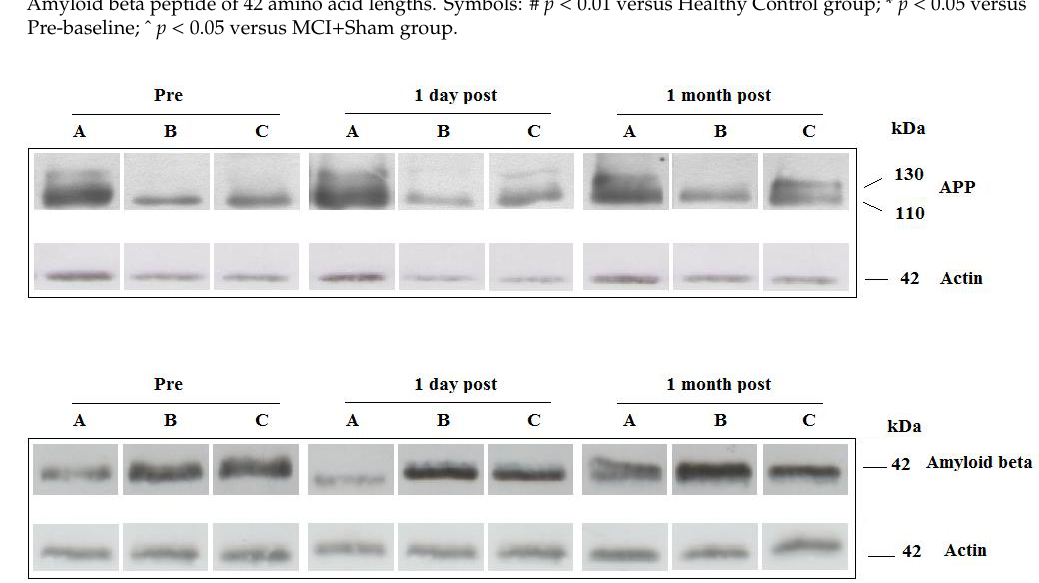
Figure 2. Western blot analysis of amyloid precursor protein (APP) forms (APP130 and APP110) and amyloid beta (Aβ) protein expression levels in the platelets collected from Healthy Control ( A ), MCI + Sham ( B ), and MCI + IHHT ( C ) groups at three time points. Beta-actin served as loading control.